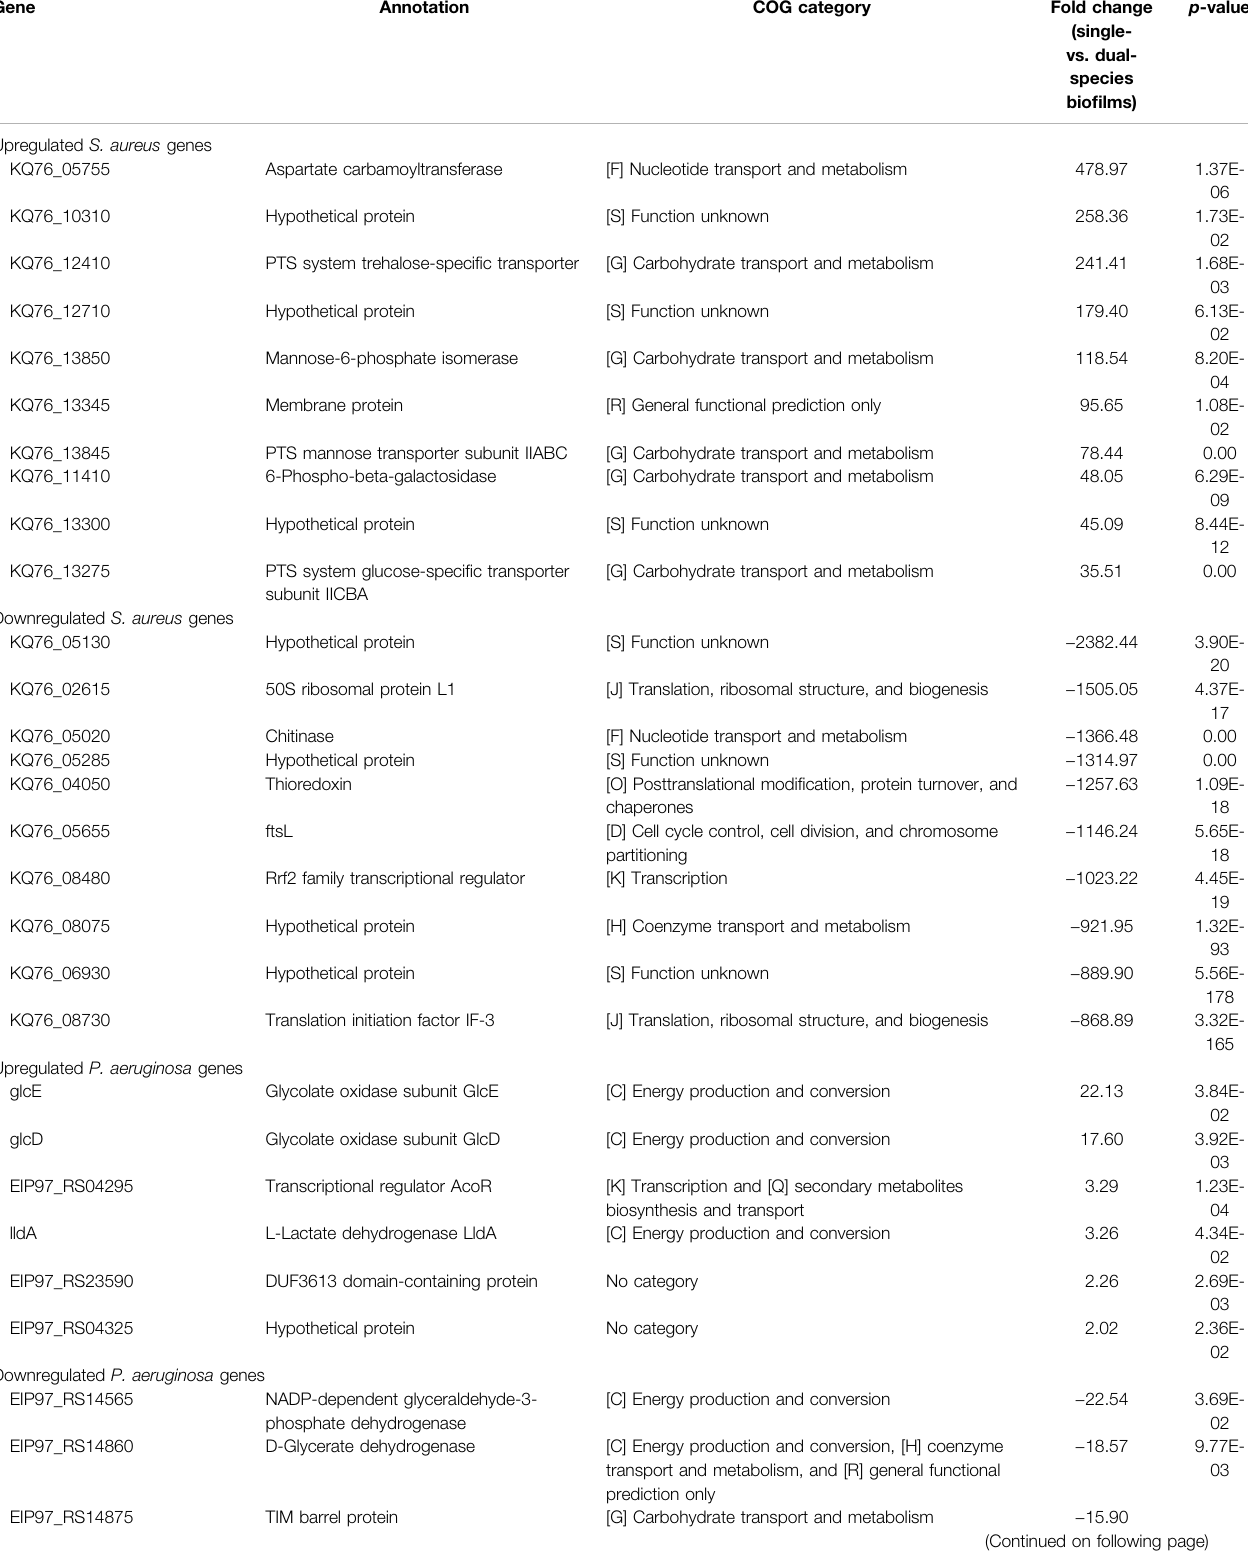
TABLE 1 | List of the 10 genes with higher fold-change among the differentially expressed genes (fold-change ≥ 2, and p < 0.05) in P. aeruginosa and S. aureus bio fi lms cultured under single- vs. dual-species conditions. COGs, Clusters of Orthologous Groups of proteins.